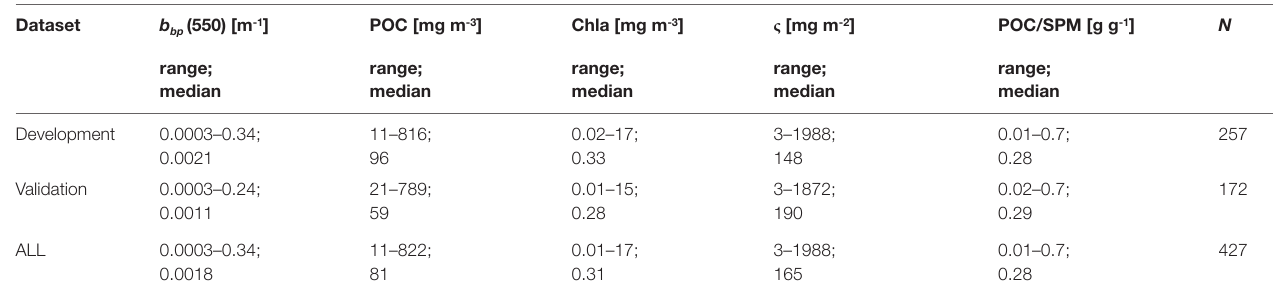
TABLE 2 | Summary of datasets.